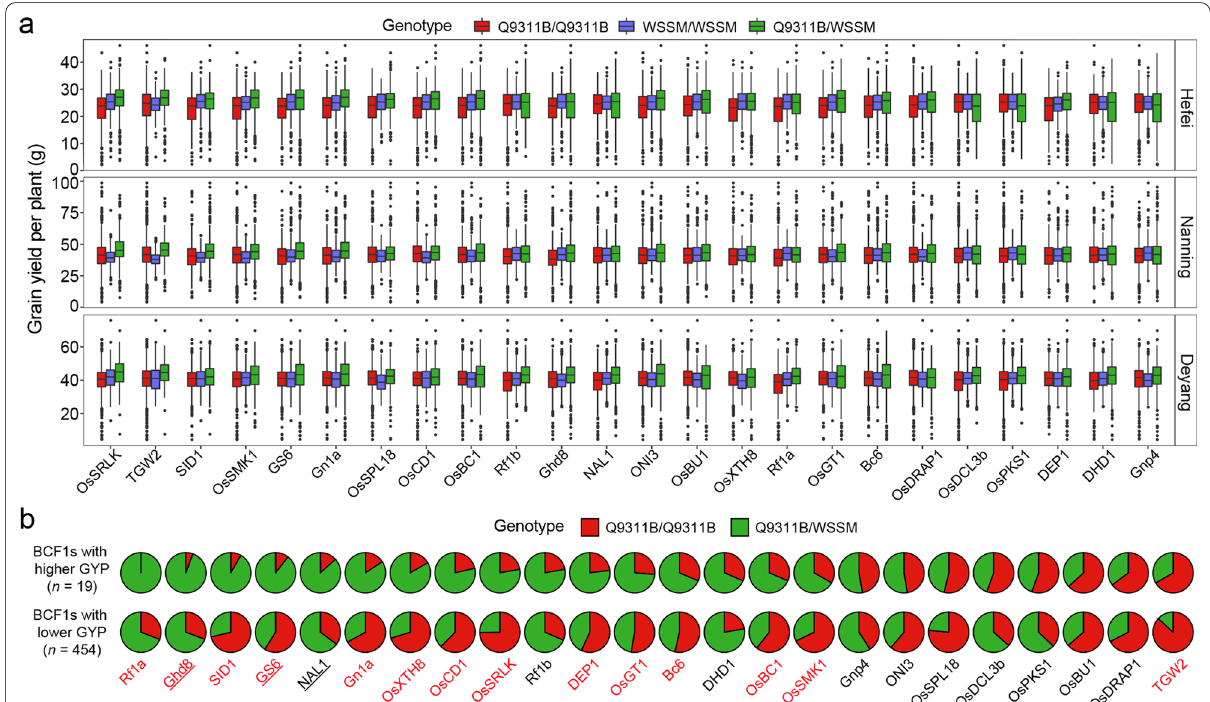
Fig. 4 Phenotypic and genotypic differences at 24 cloned genes with heterotic effects on GYP related traits. a GYP phenotypic distribution of three genotypes in the RIL and BCF 1 combined population across three environments. b Differences of allelic frequencies between the 19 superior high-yield BCF 1 hybrids and the 454 infer low-yield BCF 1 hybrids. Fisher’s exact Test (one-tail) tests were used to determine significant ( P < 0.05) differences of allelic frequencies between the 19 high-yield BCF 1 hybrids and the 454 infer low-yield BCF 1 hybrids. Gene symbols in red indicate significant differences, whereas gene symbols in black indicate no significant difference. Gene symbol with underline represents the allele of one parent may come from japonica /